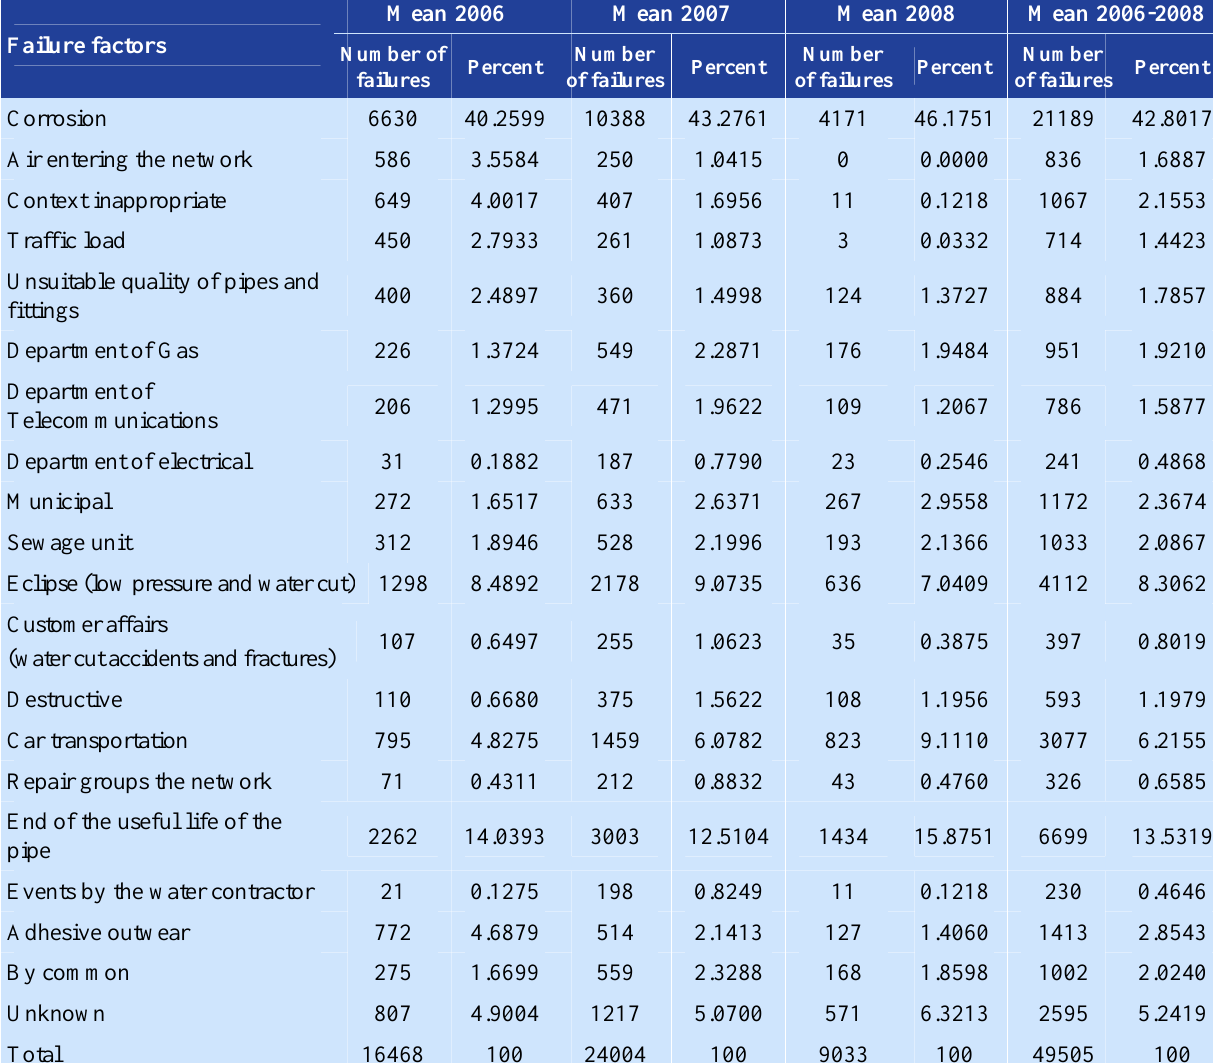
Table 2. Factors and number of failures in Ahvaz, Iran connection network during 2006-2008 (Ahvaz Water and Wastewater